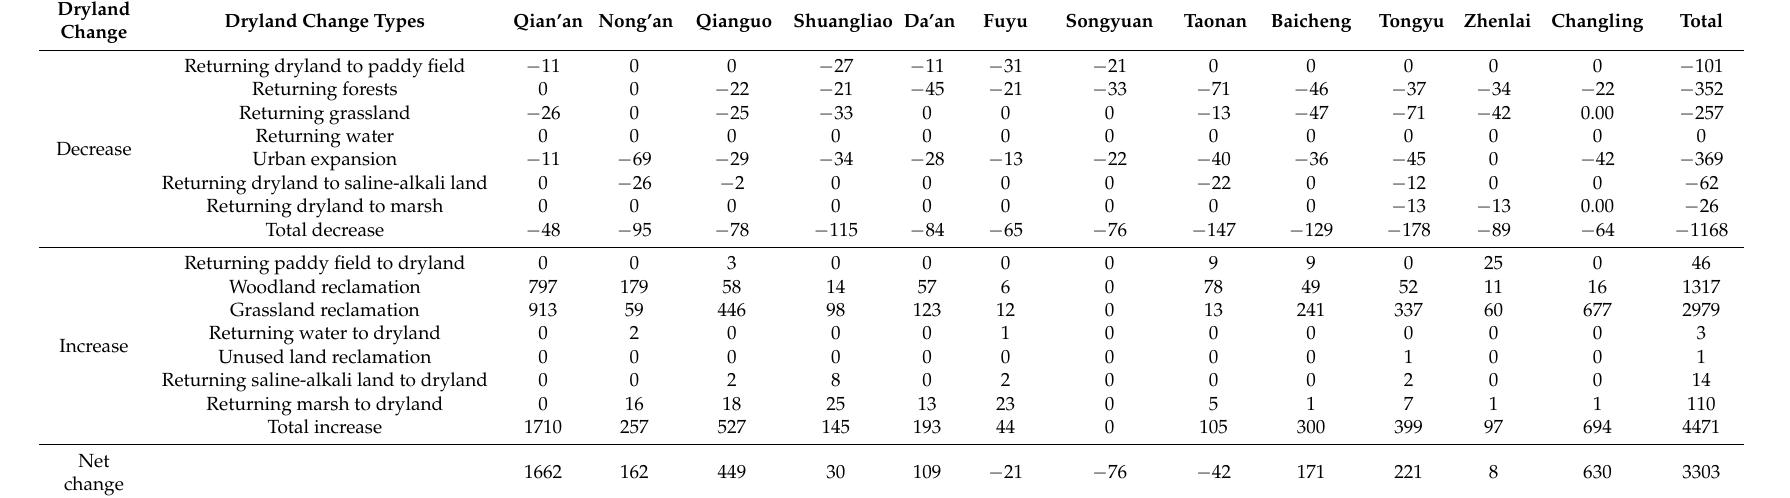
Table 2. Impact of farmland change on soybean production potential in Western Jilin during 1975–2000 (thousand tonnes). Dryland Dryland Change Types Change Returning dryland to paddy field